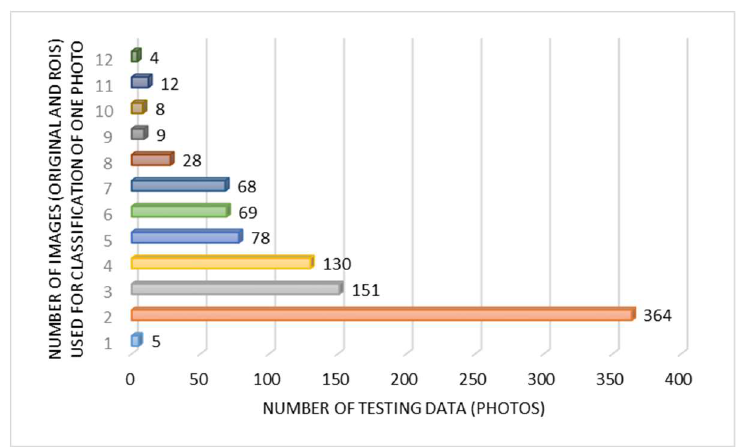
Figure 2. The number of testing data related to the number of classifications for one photo